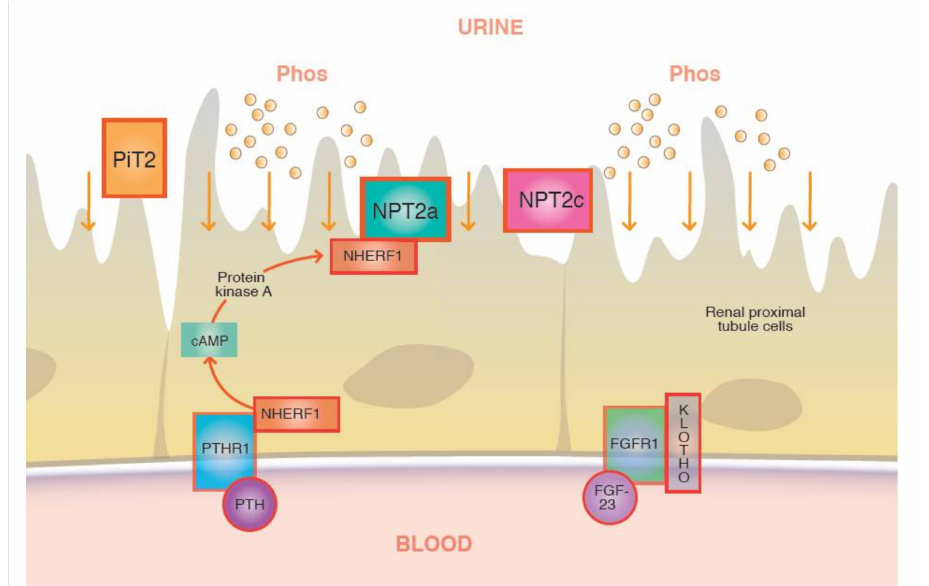
Figure 3. Binding of FGF23 to its receptor and coreceptor will downregulate the luminal sodium phosphate cotransporters (NPT2a/c) at the renal tubules through which phosphate is reabsorbed from the glomerular